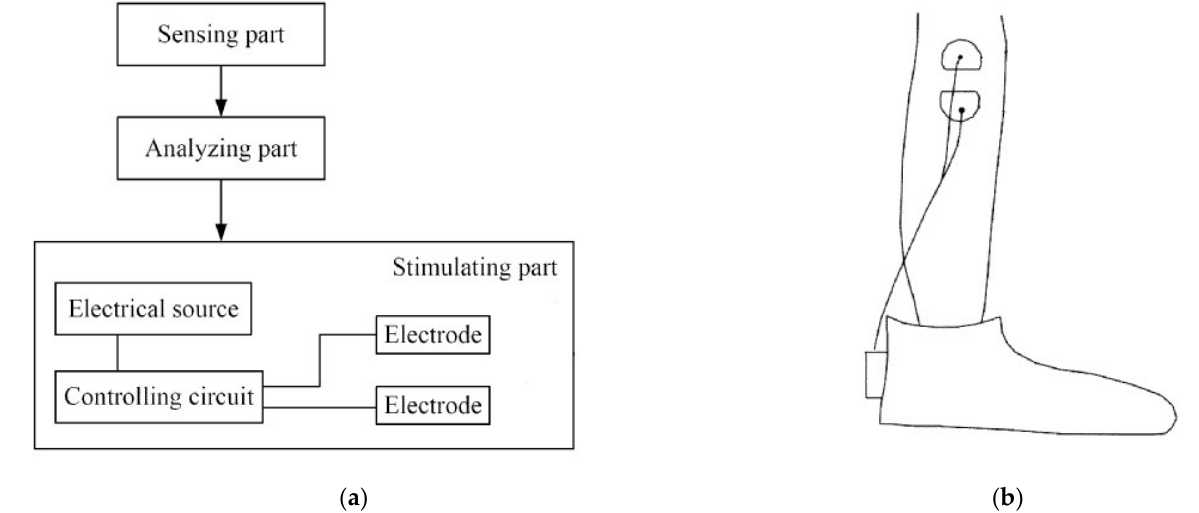
Figure 14. Methods and Devices for preventing ankle sprain injuries [66]: ( a ) schematic block diagram of the device and ( b ) device placement on lower limb, according to an embodiment of the present invention.